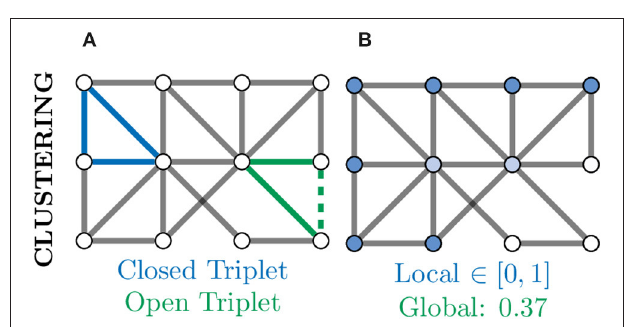
FIGURE 8 | Clustering provides another measure of connectivity and structure in a graph based on how nodes are locally connected; remember, here “local” refers to directly connected nodes in the graph and not, necessarily, physically located neurons. (A) Based the number of closed (blue) and open (green) triplets, the clustering coefficient can be calculated locally for every node. (B) Local clustering coefficients for nodes range from zero (white) to one (blue) and may vary a lot from the global (mean) clustering coefficient. Nodes with a high clustering coefficient may be involved in general aspects of information transfer and thus form an apex for